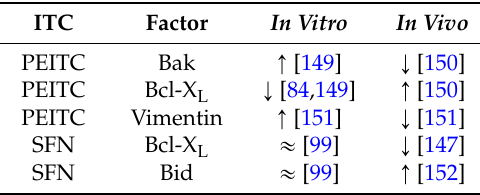
Table 4. Discrepancies in the results between ITC studies in cultured prostate cancer cell lines and animal